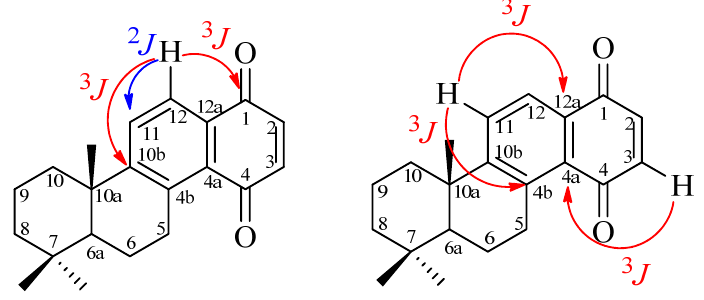
Figure 2. Major HMBC correlations observed for compound 11